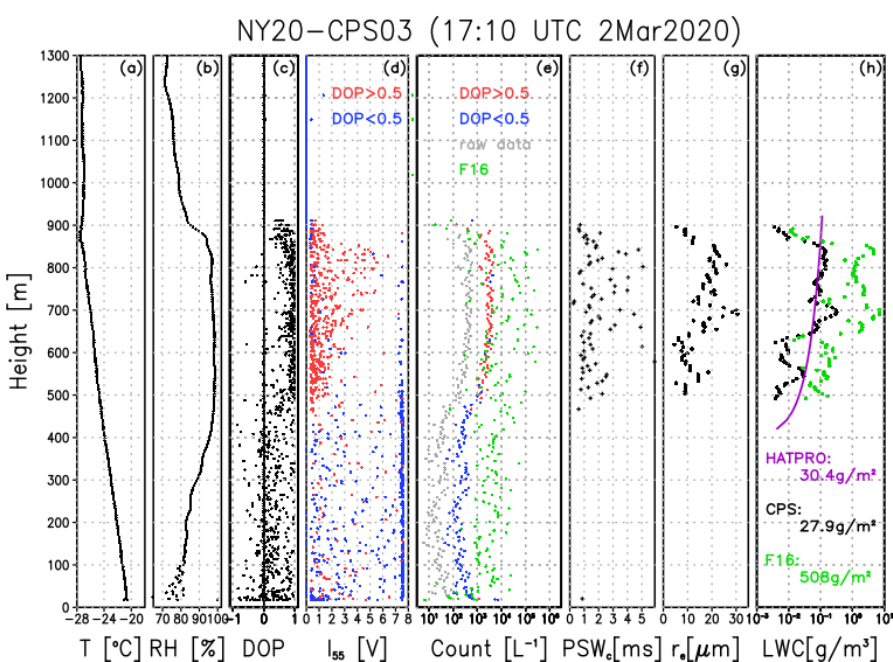
Figure 10. Vertical distributions of (a) air temperature ( ◦ C), (b) relative humidity (%), (c) DOP, (d) I 55 (V), (e) total particle count (L − 1 ), (f) PSW c (s − 1 ), (g) effective liquid particle radius, and (h) liquid water content (gm − 3 ). The numbers in panel (h) indicate the amount of the liquid water path (gm − 2 ) calculated by each method.